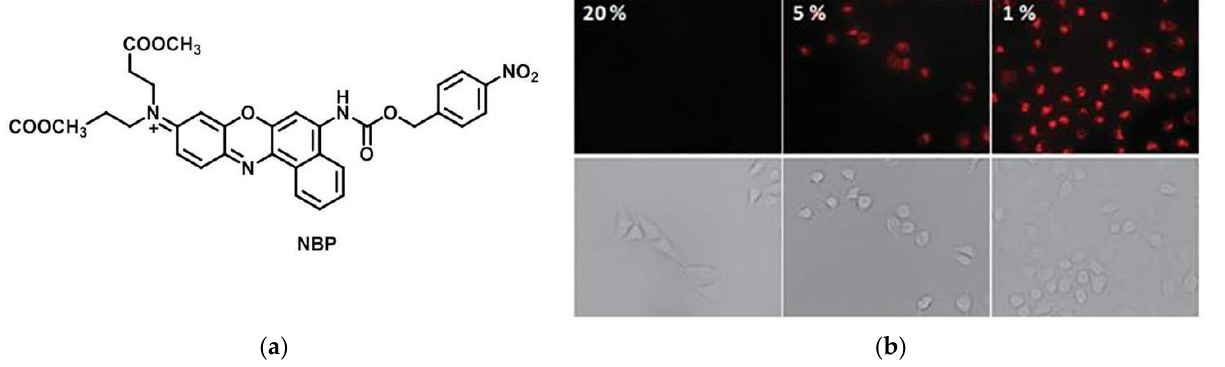
Figure 6. ( a ) Structure of probe NBP; ( b ) In the confocal imaging of A459 cells at different oxygen concentrations. Reproduced with permission from [58]. Copyright 2013 The Royal Society of Chemistry.